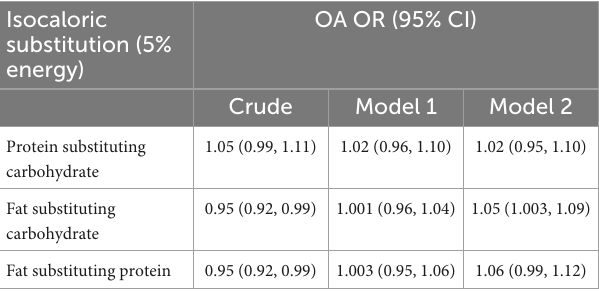
TABLE 3 Association between isocaloric substitution of macronutrients and the risk of osteoarthritis (OA) among 7,725 participants from 2013 to 2016 National Health and Nutrition Examination Survey